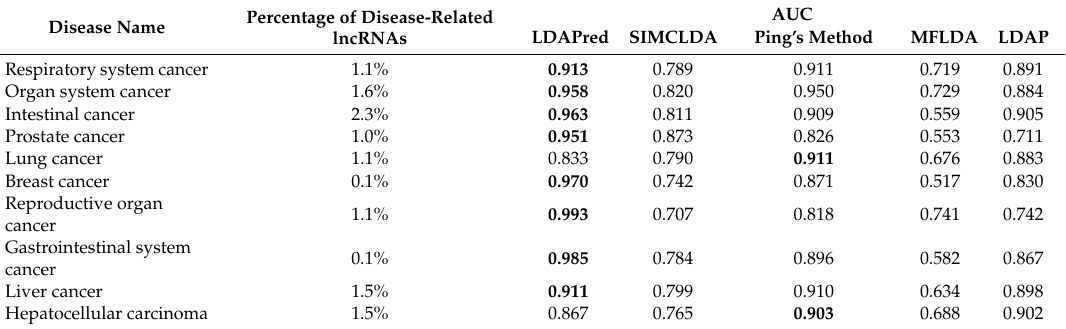
The bold values indicate the higher